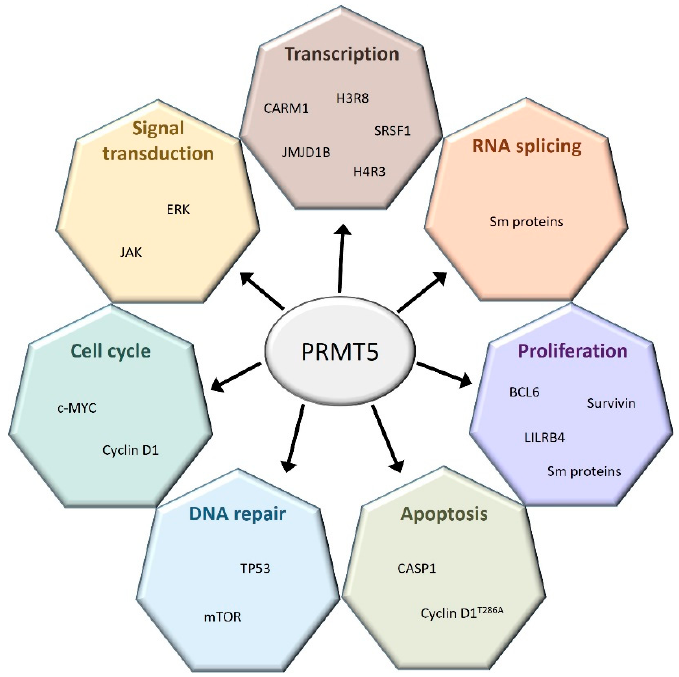
Figure 2. PRMT5 regulates a broad spectrum of cellular processes. PRMT5 interacts with many coding and non-coding genes involved in a large set of cellular functions.